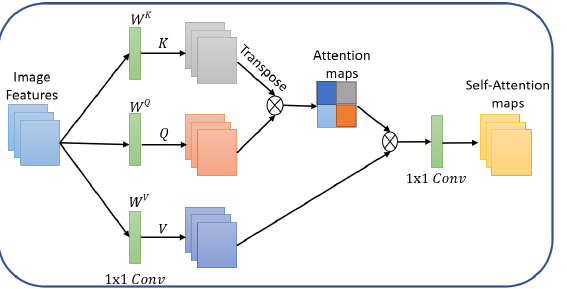
Figure 2. Self-Attention: The convolutional features that are key, query and value are computed. The attention is calculated next and applied to reweight the values. An output projection is employed to obtain output features of the same size as the